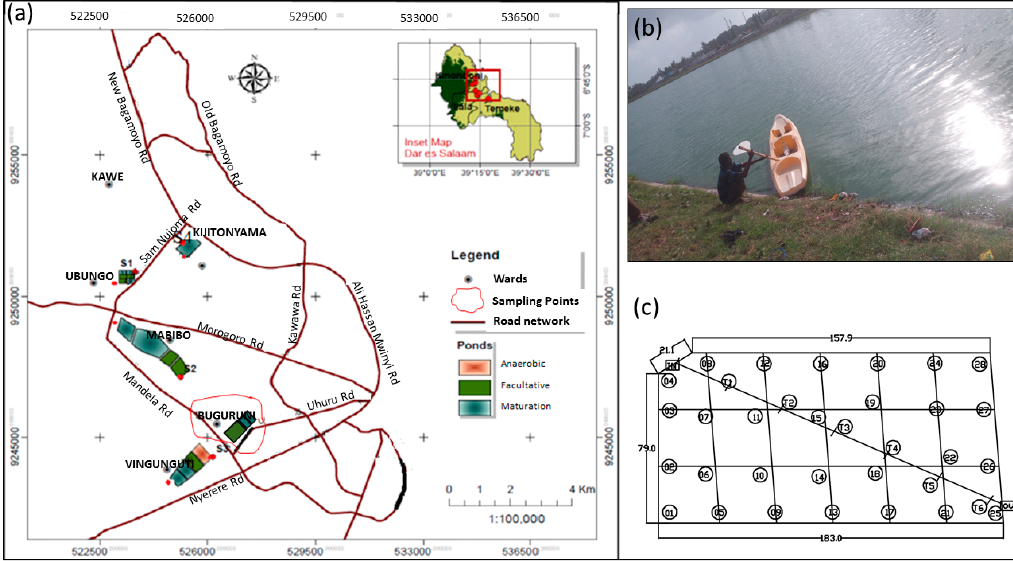
Figure 1. ( a ) Location of the Buguruni WSP from the inset map of Africa and Dar es Salaam city (modified from [21]). ( b )Photo of the facultative pond taken during a sampling campaign in December 2016. ( c ) Sampling points (node numbers in circles).